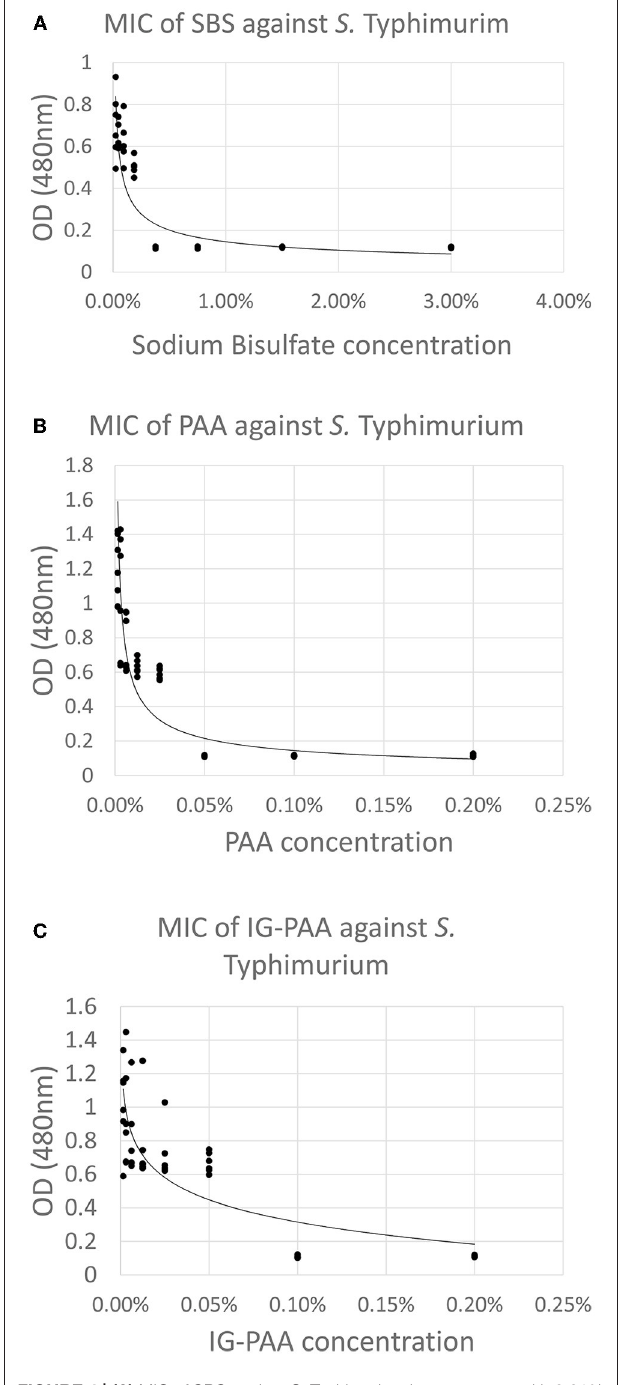
FIGURE 4 | (A) MIC of SBS against S. Typhimurium in reuse water with 0.01% TTC. One milliliter of 1% TTC was added to filtered reuse water which was inoculated with 5 × 10 7 CFU/mL S. Typhimurium UK-1. After a 24h incubation at 37 ◦ C with shaking, the absorbance at 480nm was taken and plotted against concentration ( n = 6). The MIC was determined to be 0.375% (3,750 ppm) Plots (B,C) represent MIC against PAA and IG-PAA, respectively, and were generated in the same manner as (A) , but using their respective acid sanitizers. The MIC was 0.05% (500 ppm) and 0.10% (1,000 ppm),